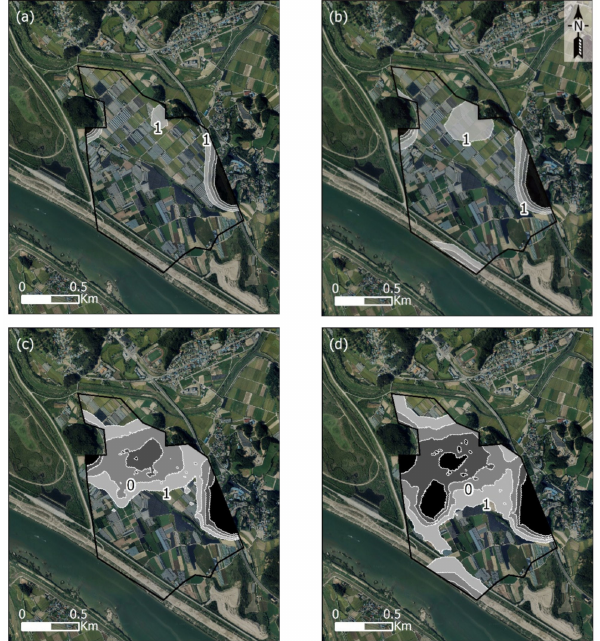
Figure 9. Areas where groundwater pumping by centrifugal pump was difficult, incorporating the spatial variation of PAT values less than 1 m (shaded area) with river levels during ( a , b ) non-seasonal pumping; ( c , d ) seasonal pumping, at ( a , c ) the Ipo Weir management level (28 m), and ( b , d ) at the minimum weir level (25.3 m).